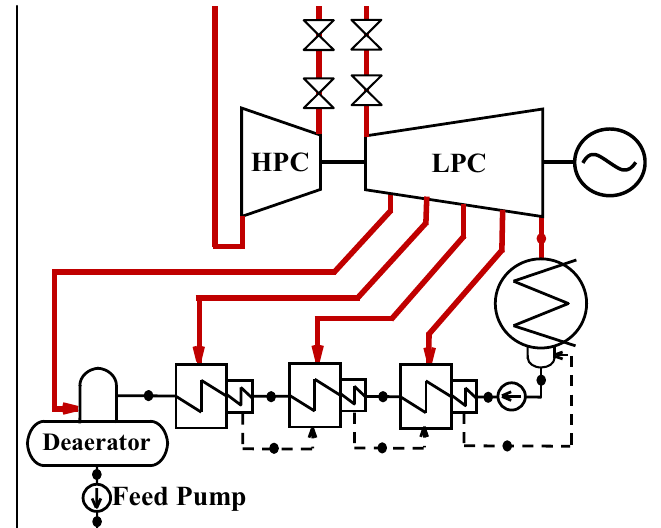
Fig. 3. Limited regenerative preheated Rankine-Hirn cycle diagram (s#2).